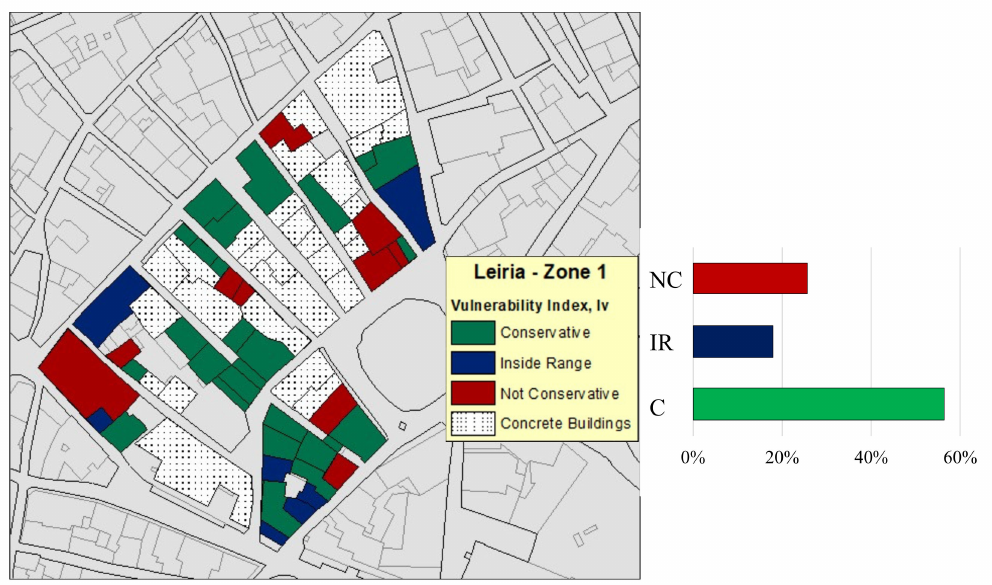
Figure 17. Comparison between the Vulnerability Indexes evaluated in this work and the reference values for the façade